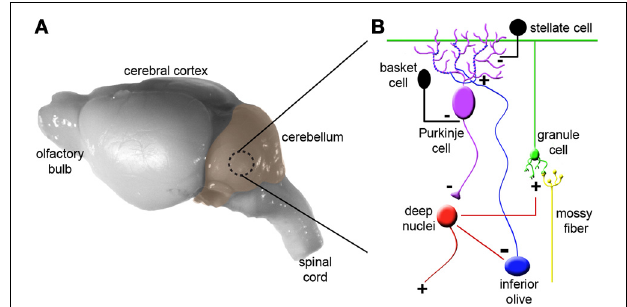
FIGURE 1 | Cytoarchitecture and connectivity in the cerebellum. (A) Mouse brain shown from a lateral view with the cerebellum highlighted in color. (B) The basic cerebellar circuit is comprised of granule cells, Purkinje cells, stellate and basket cell interneurons, and deep nuclei. Afferent information is delivered to the cerebellum as climbing fibers or mossy fibers. The plus and minus signs indicate whether each synapse is excitatory or inhibitory. Note that inhibitory connections between the cerebellar nuclei and inferior olive complete the olivo-cortico-nuclear loop and excitatory projections from the cerebellar nuclei loop back to the cerebellar cortex. Panel (B) was modified from (Reeber et al., 2012). For simplicity we have not shown Golgi cells, unipolar brush cells, Lugaro cells, and candelabrum cells.